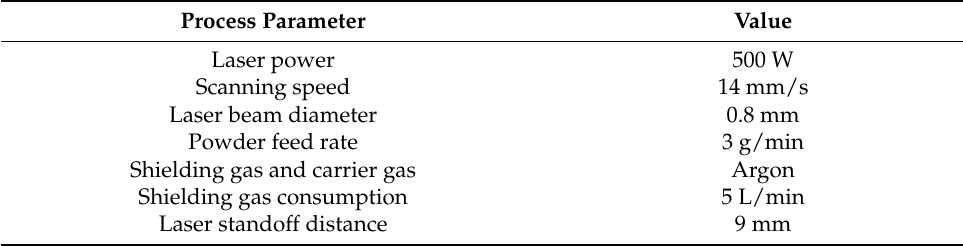
Table 1. Process parameters for single track